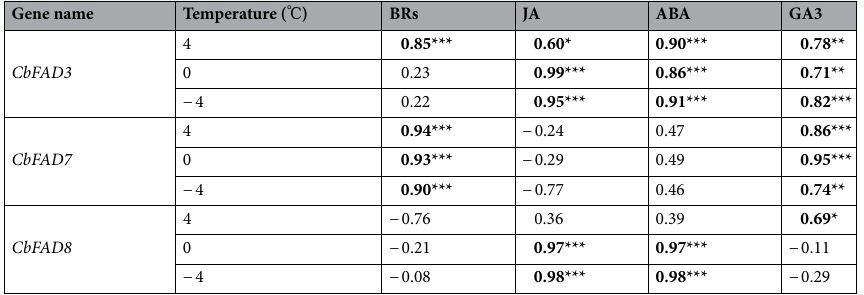
Table 2. Pearson correlation coefficients (two-tailed) between the cold-responsive and the hormone-regulated expressions of ω-3 CbFAD genes in C. bungeana leaves. Three replications for each sample, n = 5 × 3. Significant positive correlation ( R > 0.50, P < 0.05) is indicated in bold. * P < 0.05, ** P < 0.01, *** P <